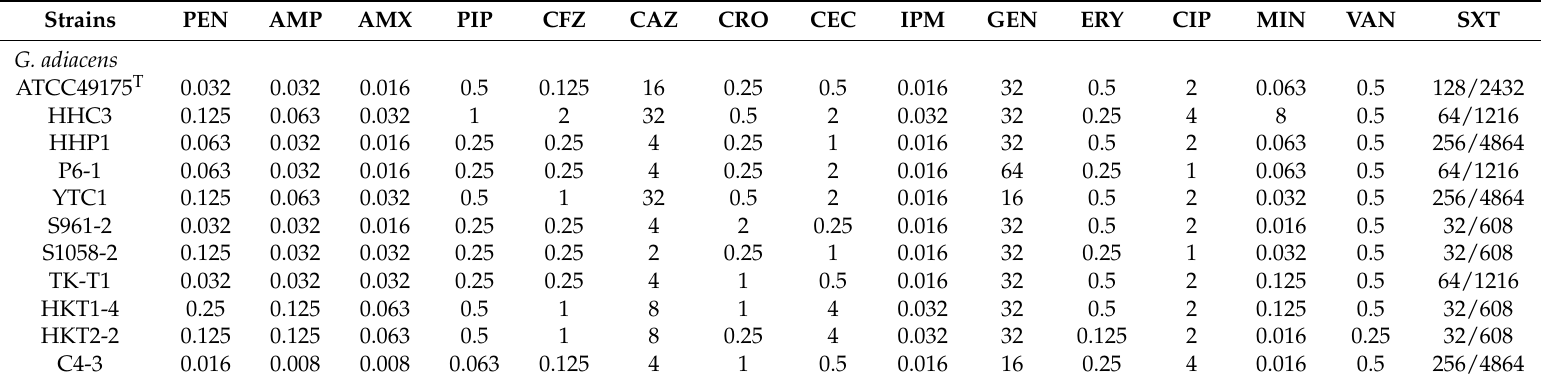
Table 2. MICs ( µ g/mL) of 15 antibiotics against Granulicatella